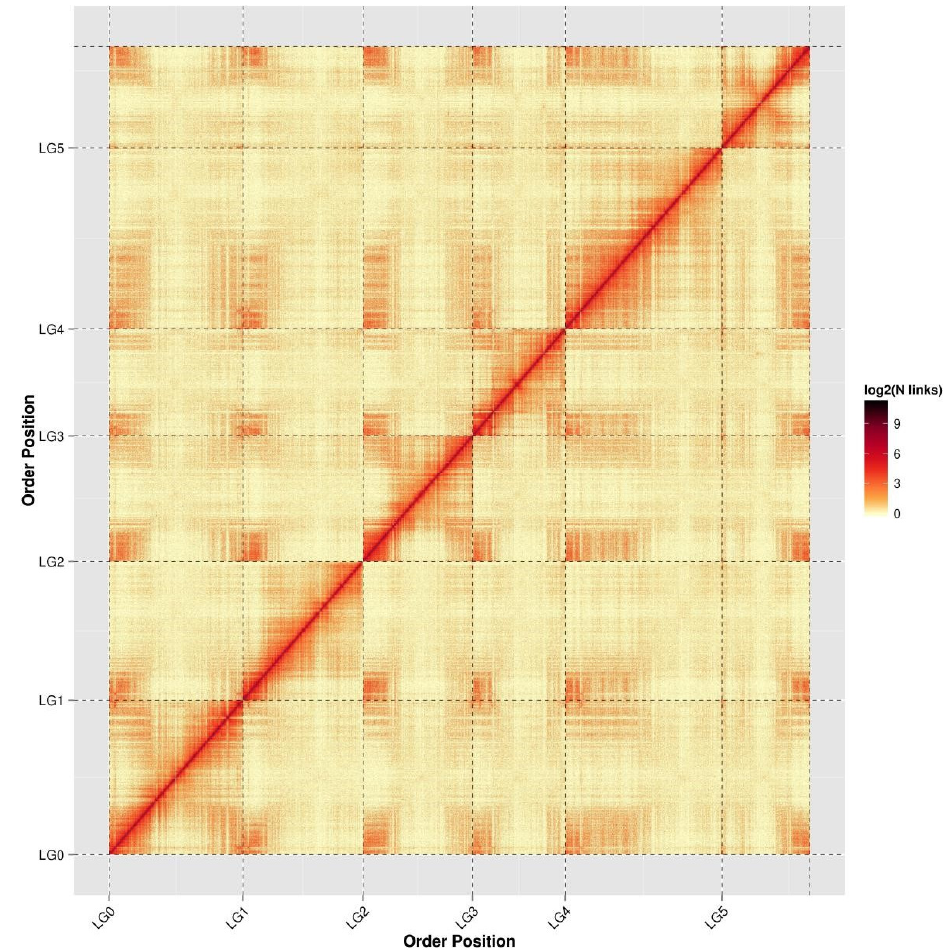
Figure 1. Hi-C assembly chromosome interaction heat map. LG0–LG5 represent LACHESIS groups 0–5. The abscissa and ordinate represent the order of each bin on the corresponding chromosome group.